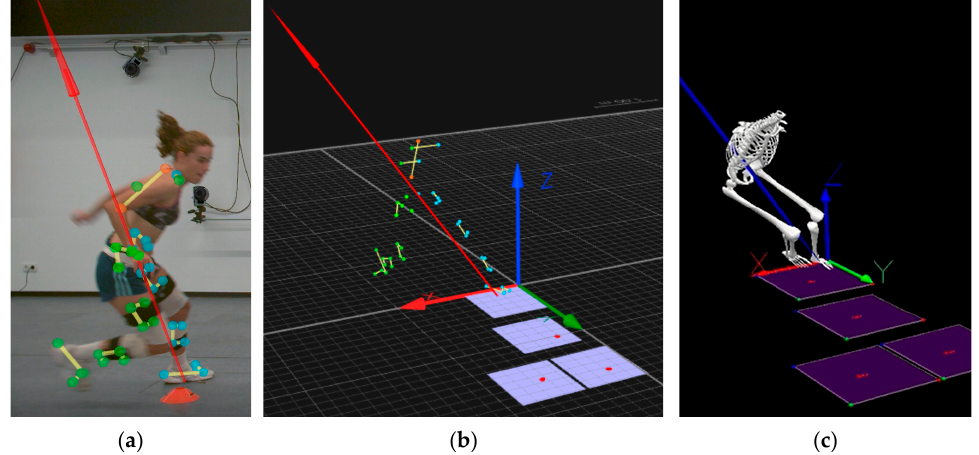
Figure 1. Capture moment of kinematic data during CODAT test: ( a ) Capture moment from a 2D camera that shows the player’s task; ( b ) Signal from 12 infrared high-speed cameras being processed with Visual3D software; ( c ) Final avatar processed by Virtual 3D software.